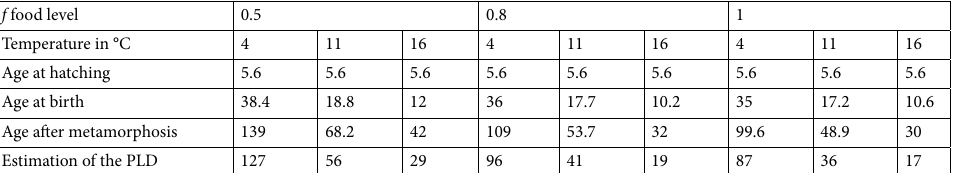
Table 4. Predictions of the different larval stages and settlement ages according to different environmental scenarios in the North Atlantic Ocean. The temperature at hatching was one of the in situ temperatures (4 °C). PLD represents pelagic larval duration, which encompasses the time between the trochophore stage (hatching) and the settlement of the pediveliger stage. We postulated that it took at least one week to complete the metamorphosis period from the pediveliger stage. Values are in